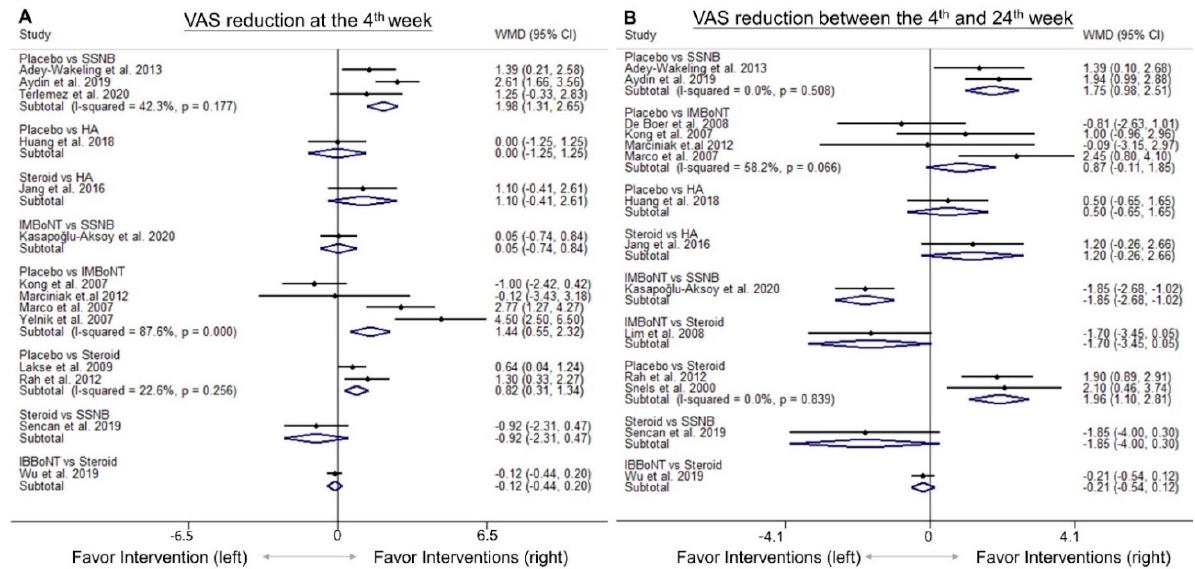
Figure 2. Forrest plots for the available direct comparisons between pairs of treatments among the included studies regarding the effects of VAS reduction ( A ) at the 4th week and ( B ) between the 4th and 24th weeks after interventions. BoNT, botulinum toxin; HA, hyaluronic acid; IB, intra-bursal; IM, intra-muscular; SSNB, suprascapular nerve block; VAS, visual analogue scale; WMD, weight mean difference.